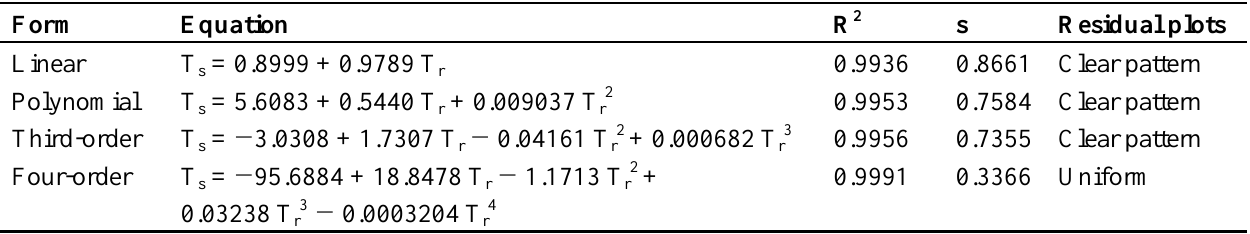
Table 4. Calibration equations and statistics of TROTEC BP-20 infrared thermocouple within the ranged from 13  C to 37 